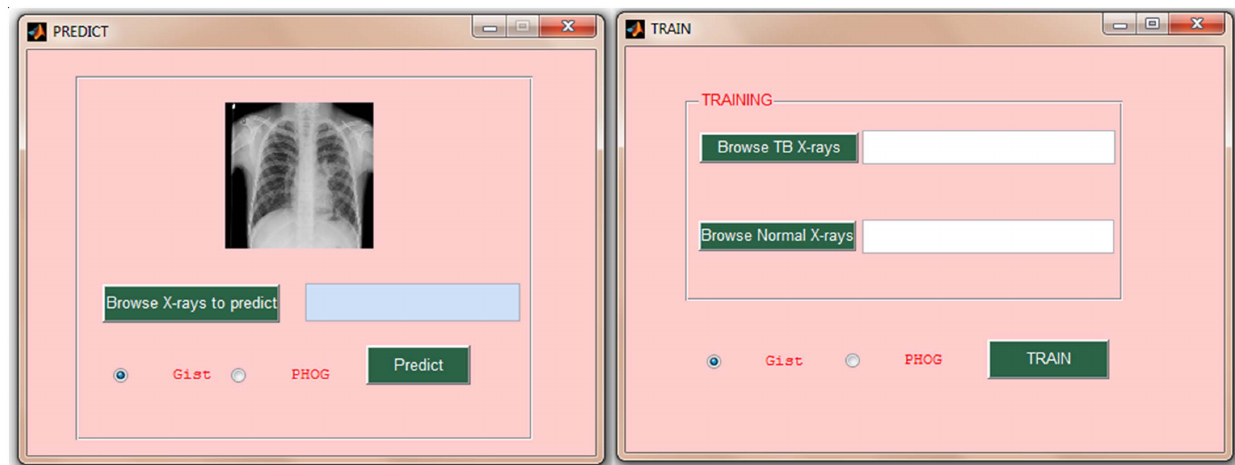
Figure 9. GUI of Prediction and Training Modules in Matlab toolbox, TB-Xpredict.